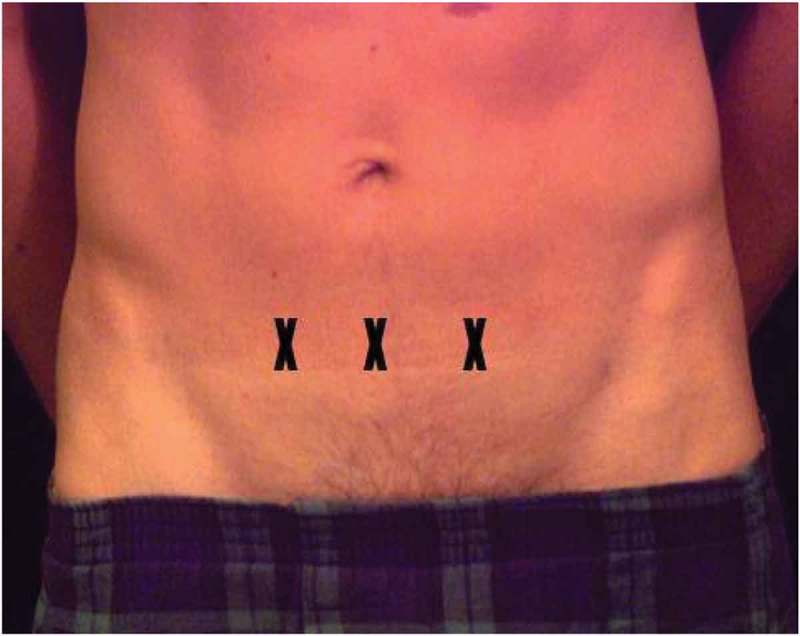
Sites of shockwaves exposure.